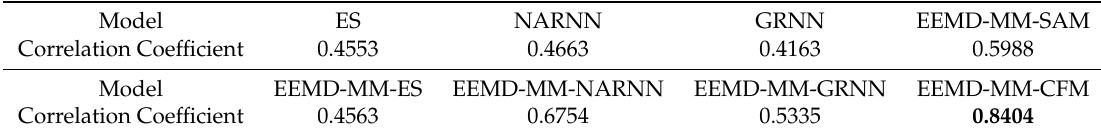
Table 2. The correlation coefficient of the proposed model.